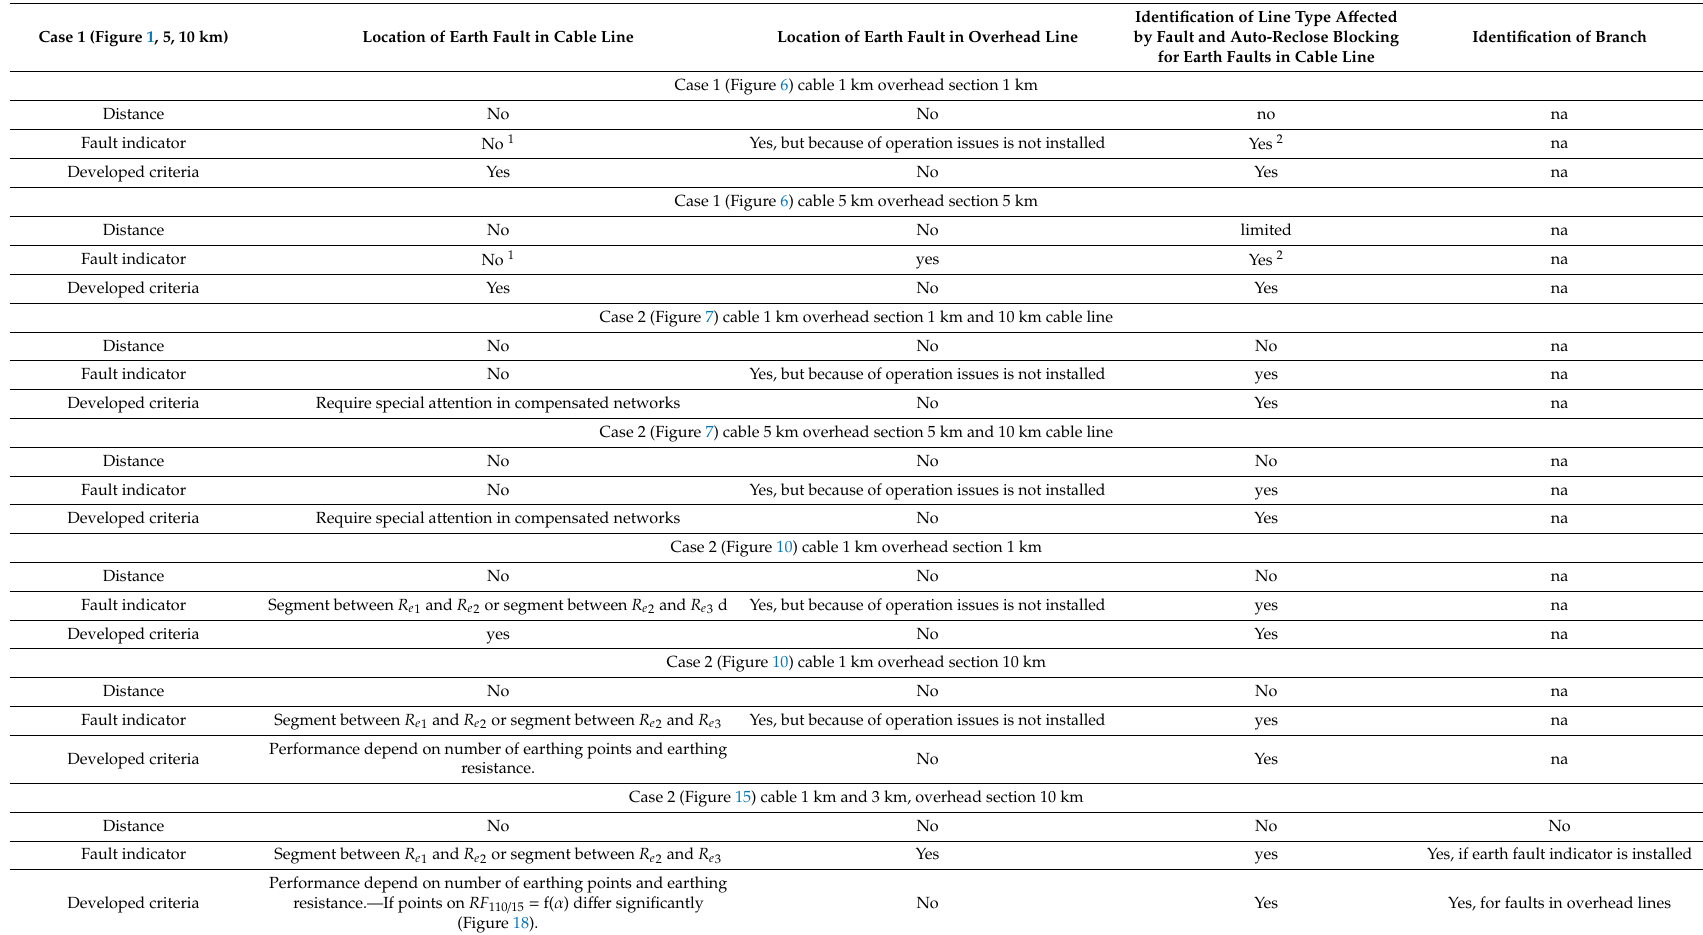
Table 3. Performance of the RF / α , fault current indicators and distance relay for earth faults in MV